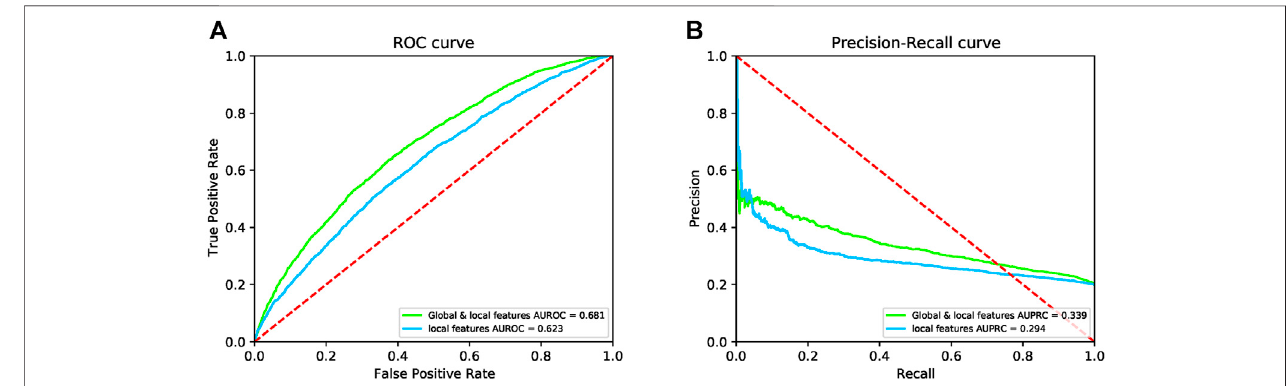
FIGURE 6 | The ROC curves (A) and the precision-recall curves (B) for both local and global & local features on the independent test.